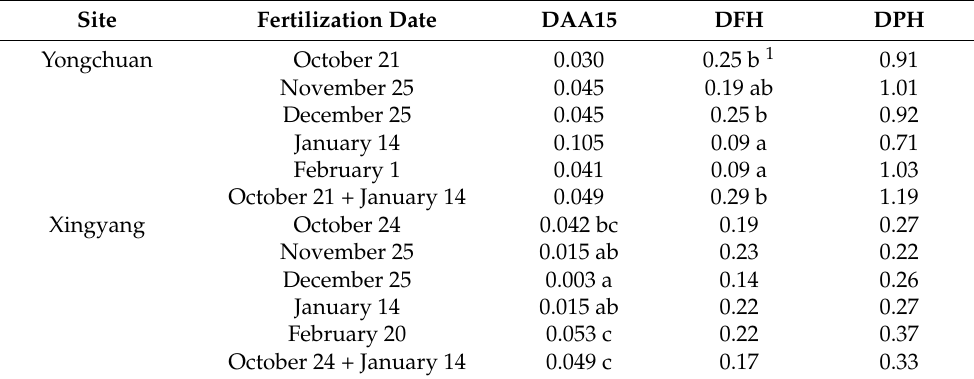
Figure 3. N dff% of fibrous root ( a ) and mature leaves ( b ) 15 days after 15 N fertilization (DAA15), on the days of first harvest (DFH) and post-harvest (DPH) of spring shoots at Yongchuan, Chongqing province. The data are means and SE ( n = 4). Single bars without symbols above columns represent LSD values indicating significant differences among DAA15, DFH, and DPH for each of the specified fertilization dates. A single bar without a symbol ticked with (LSD) in ( b ) represents LSD value indicating significant difference on DFH among fertilization dates. Table 2. Leaf/root ratio of N dff% (LN dff% /RN dff% ) measured 15 days after 15 N application (DAA15), on the days of the first harvest (DFH) and post-harvest (DPH) of young spring shoots at Youngchuan